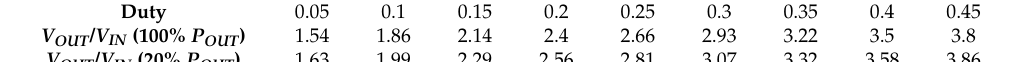
Table 4. Values of the converter’s voltage gain in dependency on the duty cycle.